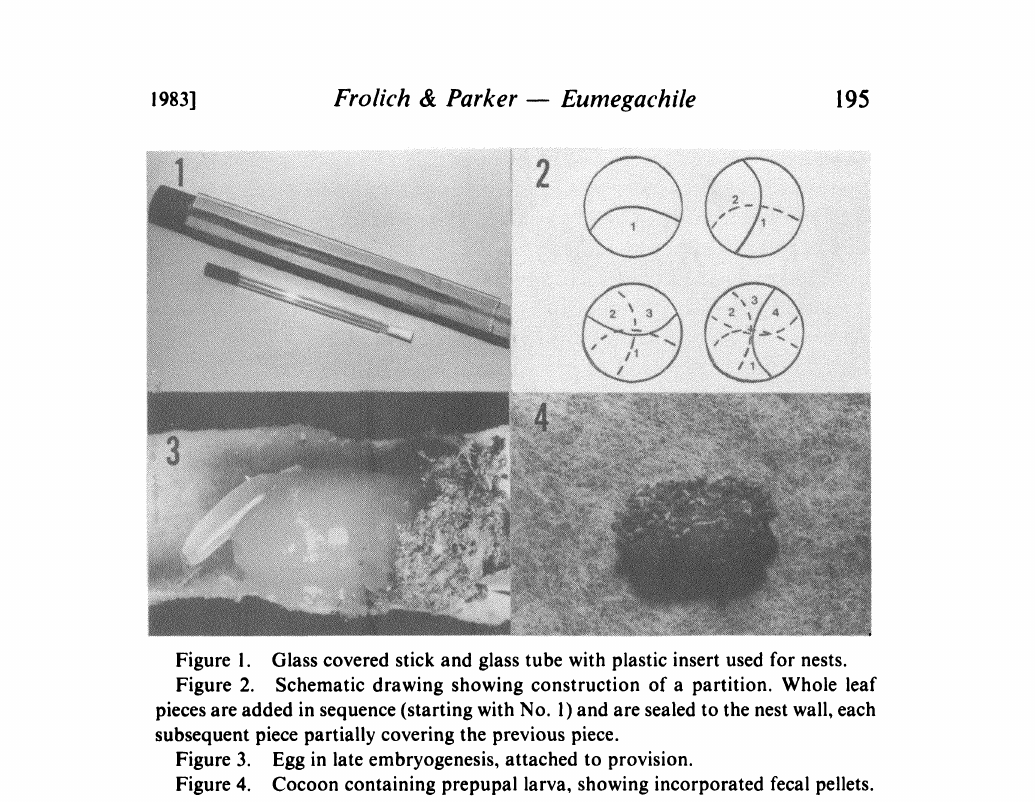
Figure I. Glass covered stick and glass tube with plastic insert used for nests. Figure 2. Schematic drawing showing construction of a partition. Whole leaf pieces are added in sequence (starting with No. 1) and are sealed to the nest wall, each subsequent piece partially covering the previous piece. Figure 3. Egg in late embryogenesis, attached to provision. Figure 4. Cocoon containing prepupal larva, showing incorporated fecal